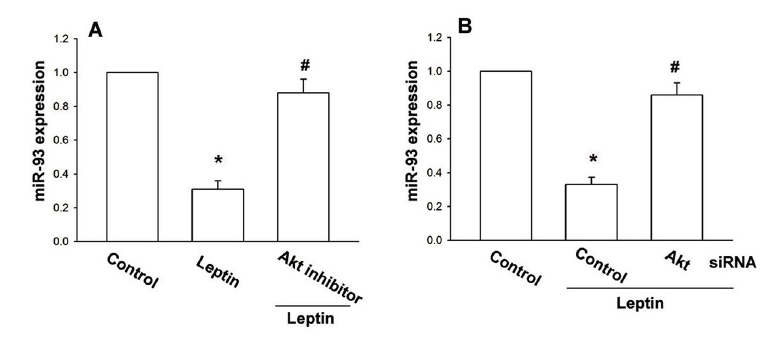
Figure 5. Leptin increases OSM expression by inhibition miR-93 through the Akt pathway. Osteoblasts were pretreated with Akt inhibitor (10 µM) ( A ) for 30 min or transfected with Akt siRNA ( B ) for 24 h followed by stimulation with leptin (30 nM) for 24 h; miR-93 expression was measured by qPCR. Results are expressed as the mean ± SEM; * p < 0.05 as compared with the basal level; # p < 0.05 as compared with the leptin-treated